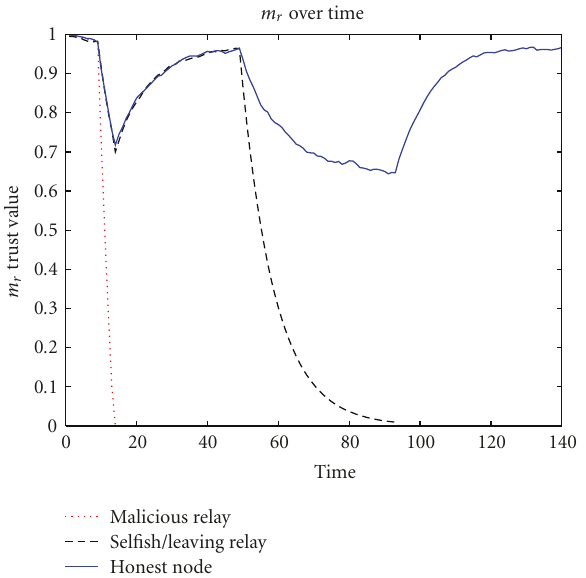
Figure 5: Trust value (i.e., m i value) over time with estimation error and untrustworthy relays (attacks at time 10 and time 50).